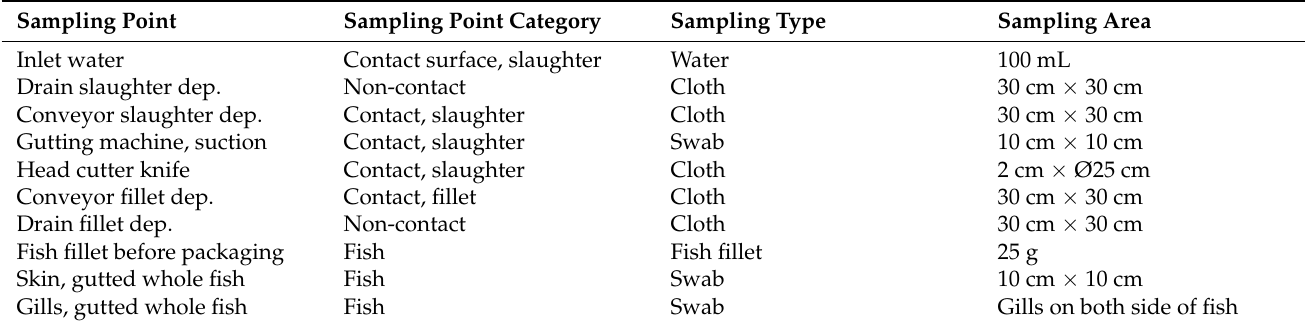
Table 1. Overview of the different sampling points, sampling point category; CSS = contact